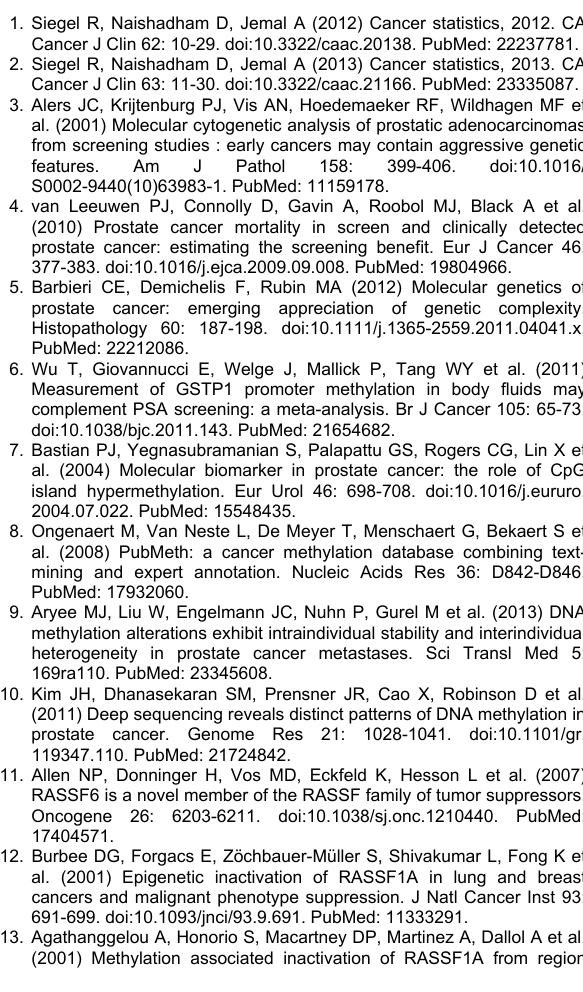
Table S3. Summary of primer sequences used in methylation study of